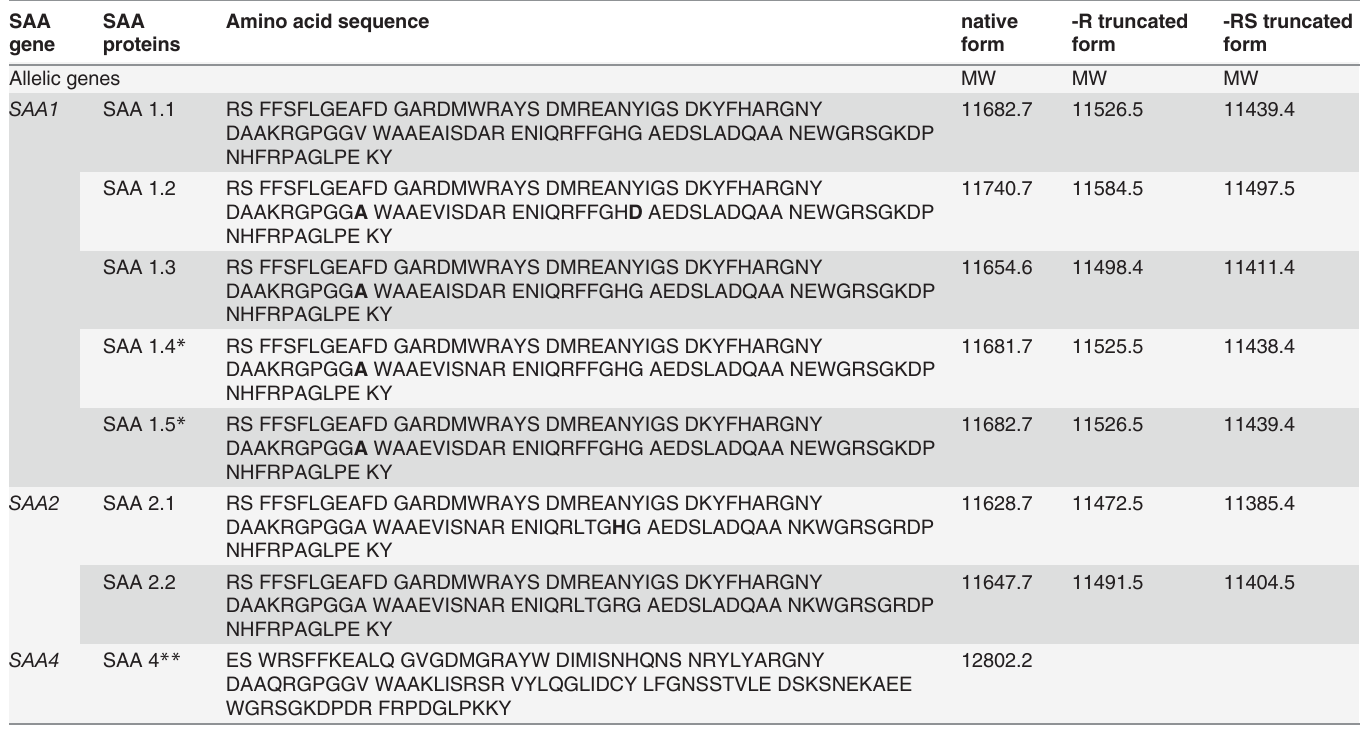
Table 2. SAA isoforms detected by MSIA.